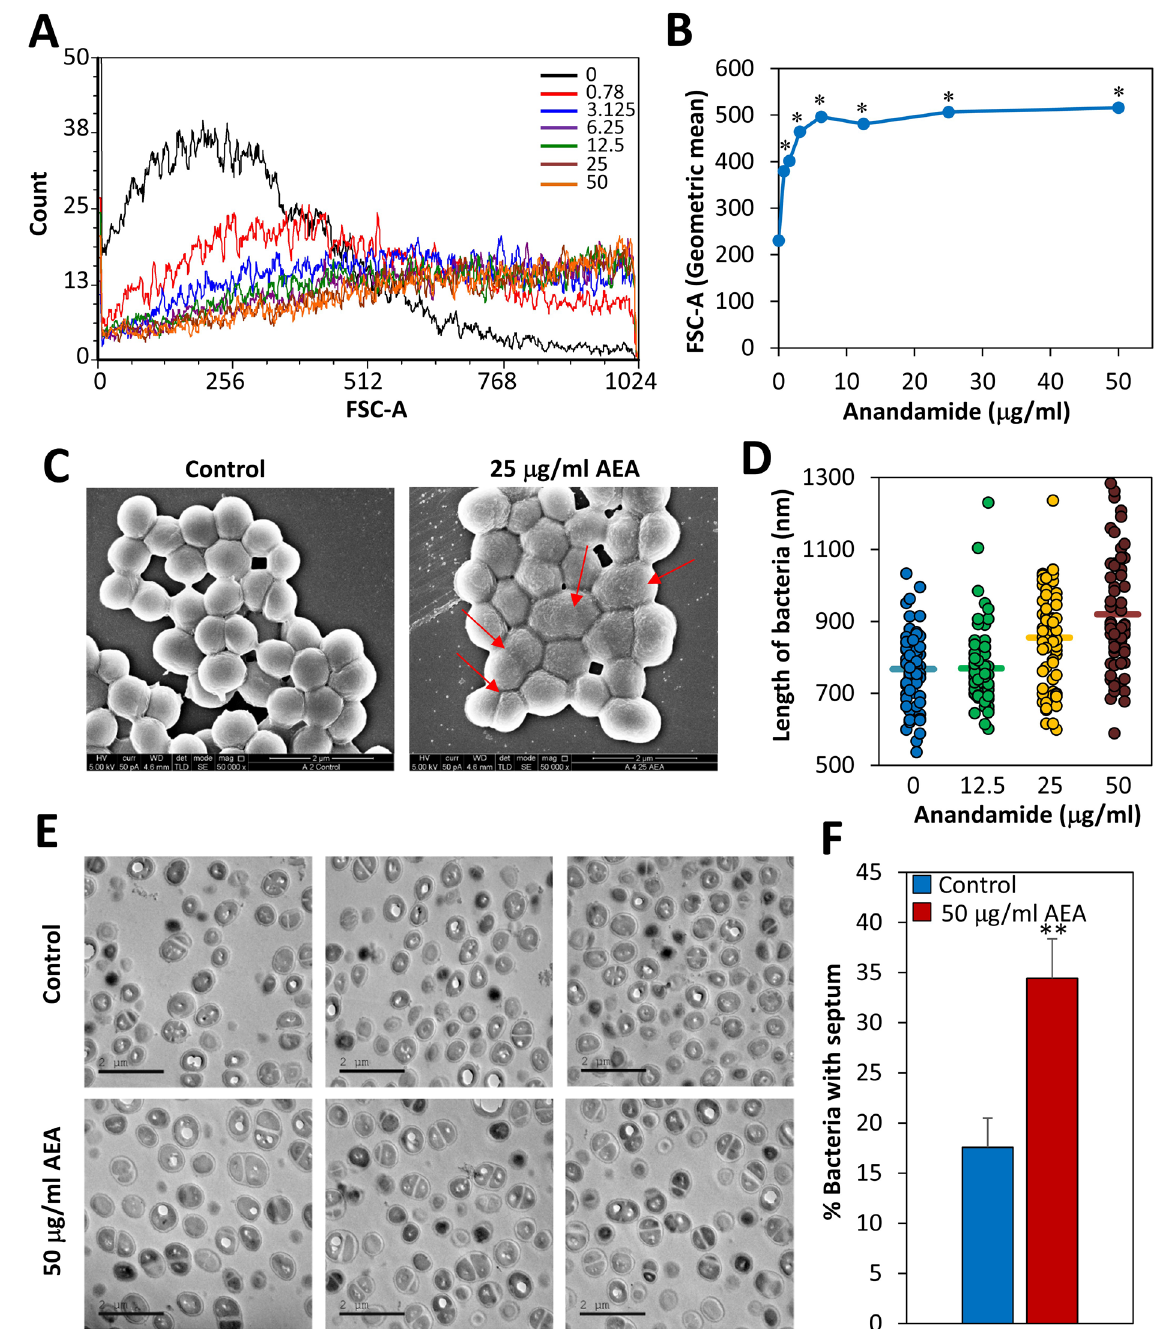
Figure 5. AEA changes the structure of the bacteria and increases the number of bacteria with complete septum. ( A ) Forward scatter on flow cytometry of bacteria treated with various concentrations of AEA for 2 h. ( B ) The graph shows the mean geometric FSC of data presented in ( A ). ( C ) SEM images of control bacteria or bacteria treated with 25 μg/ml AEA for 2 h. The red arrows point to bacteria that are larger and seem to be in division, but did not yet separate. The AEA-treated bacteria show ruffled membranes, which is in contrary to the control bacteria with smooth membranes. ( D ) The length of the bacteria after a 2 h treatment with AEA compared to control bacteria. n = 65–70 for each treatment group measured from 4–5 independent images. The horizontal lines present the average size. The y axis is set within the range of the cell sizes. ( E ) TEM images of control and AEA-treated bacteria for 2 h. ( F ) The graph presents the percentage of bacteria showing complete septum. 840–890 bacteria were counted in 6 different images of each sample. **p <